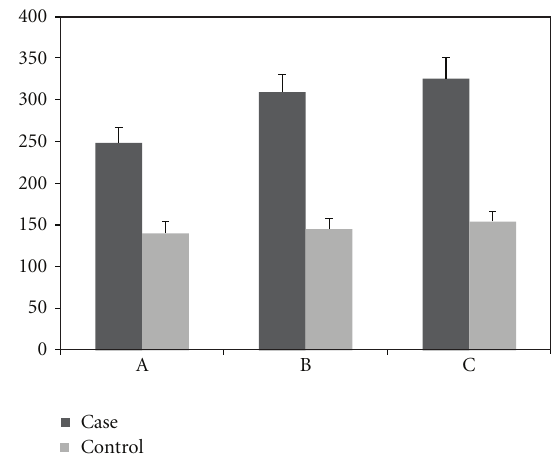
Figure 2: An estimate of LDH (units/L) in flasks of WEHI-164 fibrosarcoma cells 48 h after treatment with 10 (A), 50 (B), or 100 (C) hydatid cyst protoscolices compared with control cells (mean of triplicate